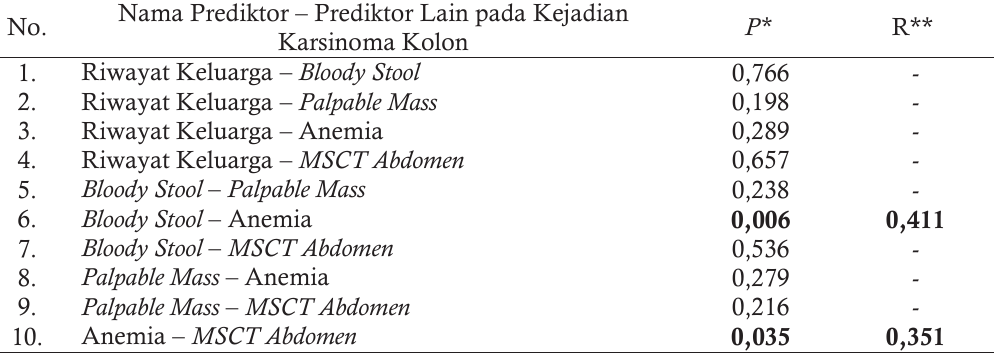
*Correlation test with Chi-square, significant only if p<0.05 **Power or correlation with Spearman-Kendall bivariate correlation test, significant only if p<0.05 Tabel 3. Inter variables correlation (family history, bloody stool, palpable mass, anemia, and abdominal MSCT) on Colon Carcinoma